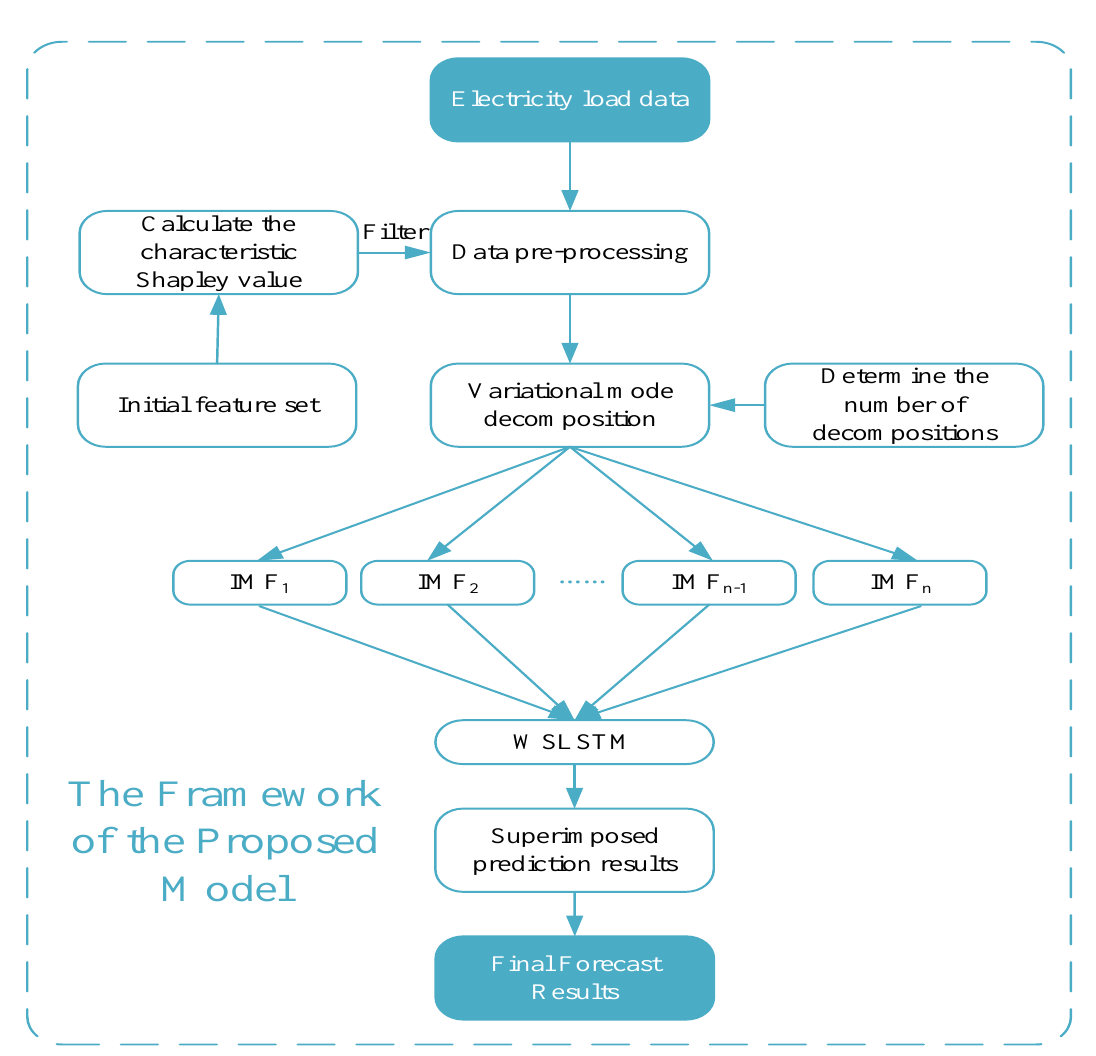
Figure 3. Structural framework of the proposed model.